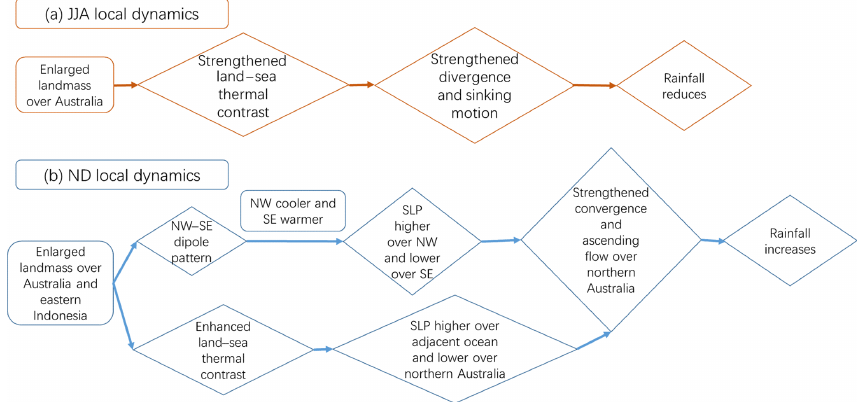
Figure 16. Mechanisms of Australian monsoon precipitation change (a) in JJA, and (b) in ND during the LGM, in the local dynamics